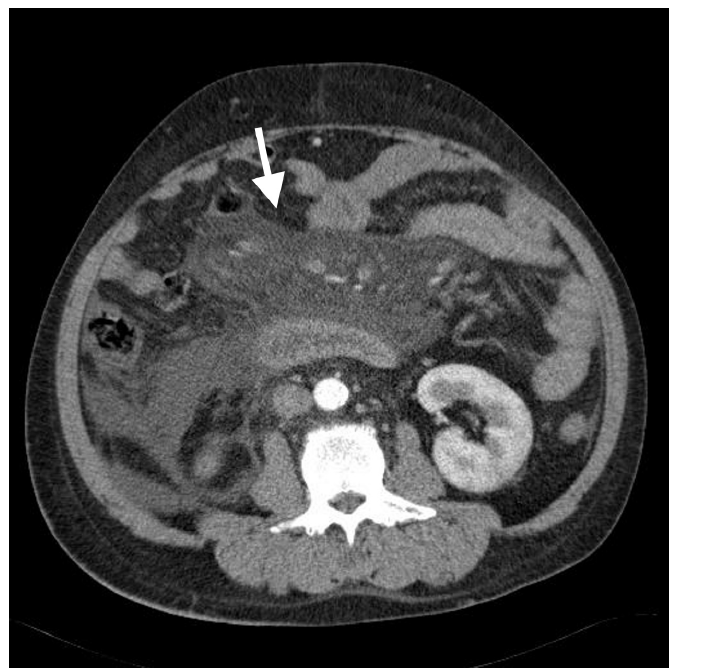
Image 1. Computed tomography showing “misty mesentery” fat stranding (arrow) surrounding mesenteric vessels with